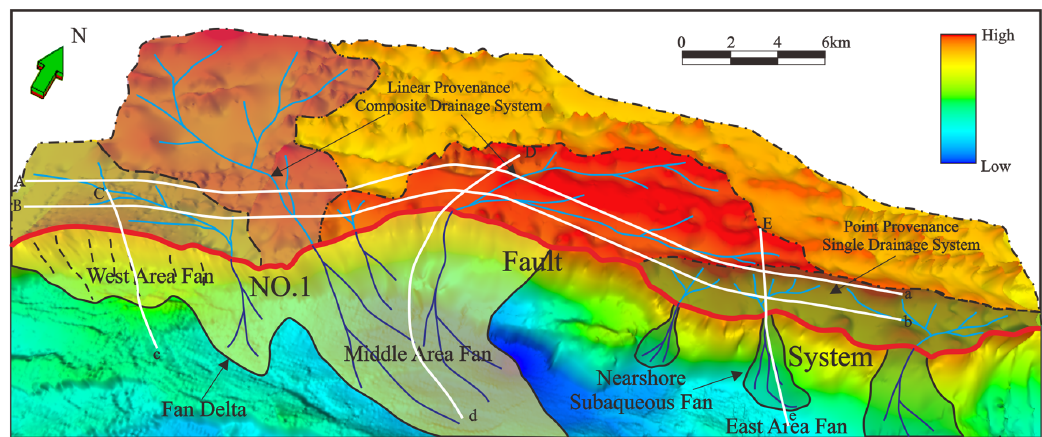
and extension length). The differences between the west, middle, and east areas are compared (Figure 4 and Table 1).